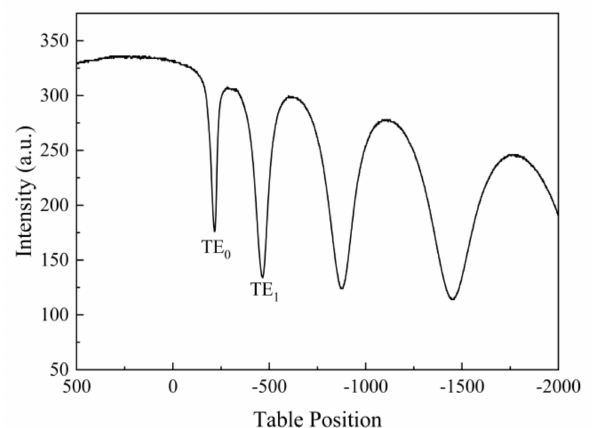
Figure 3. Optical guided TE modes of the composite film containing 5 wt. % azobenzene and heated at 200 ◦